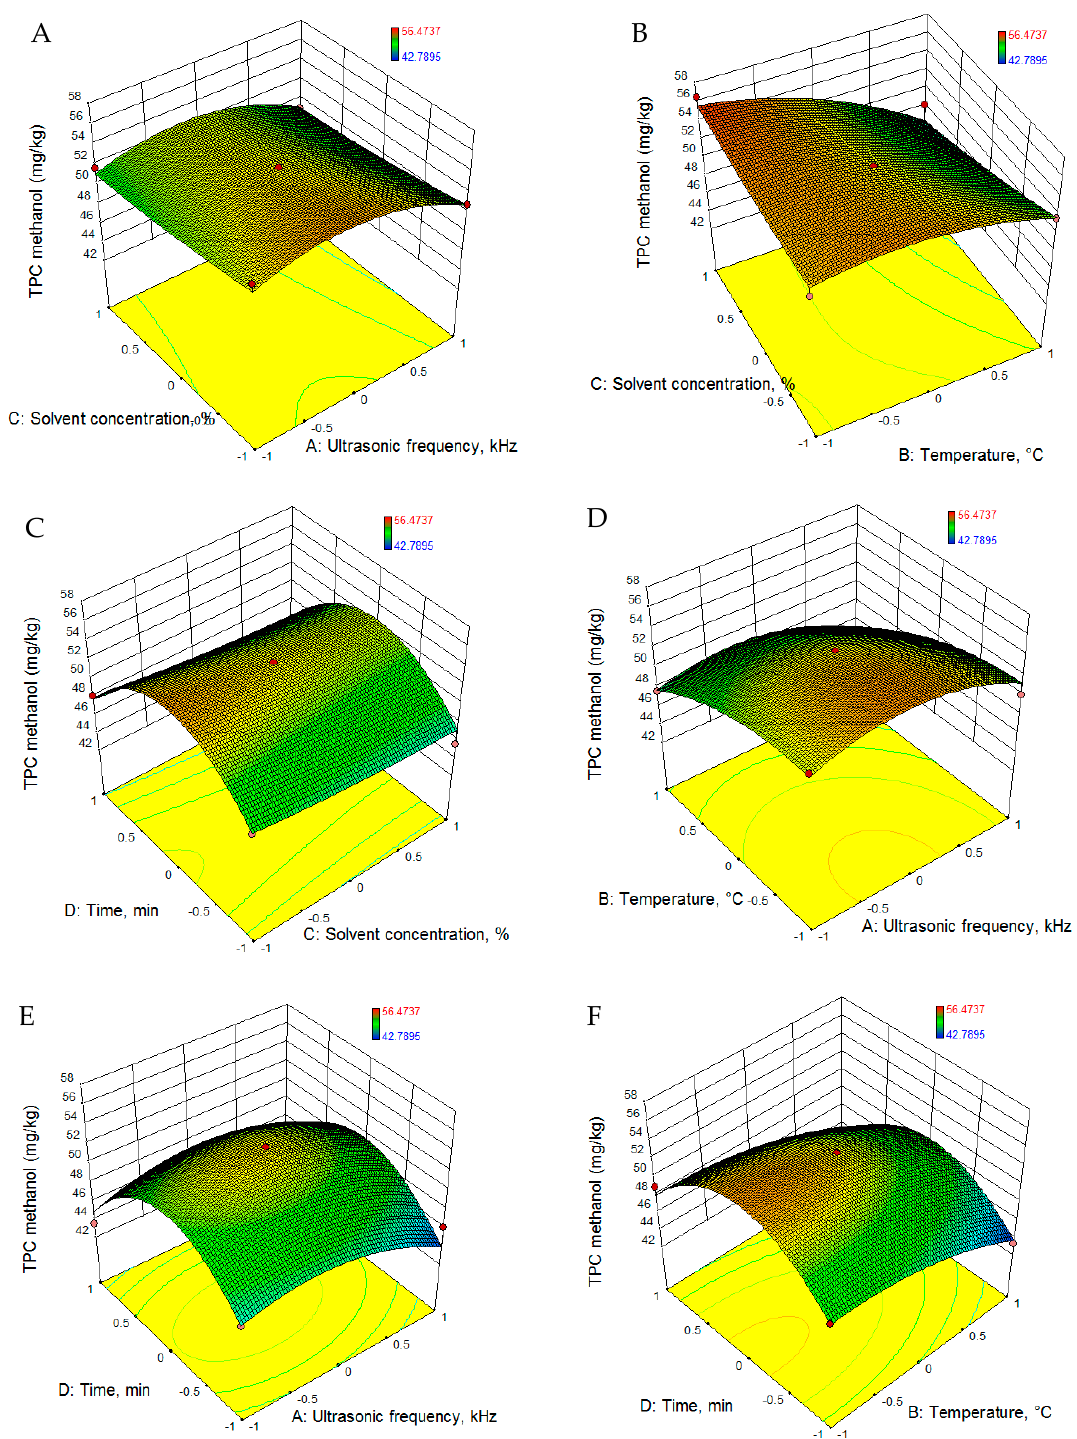
Figure 4. RSM graphs of TPC extraction evolution using methanol as solvent.